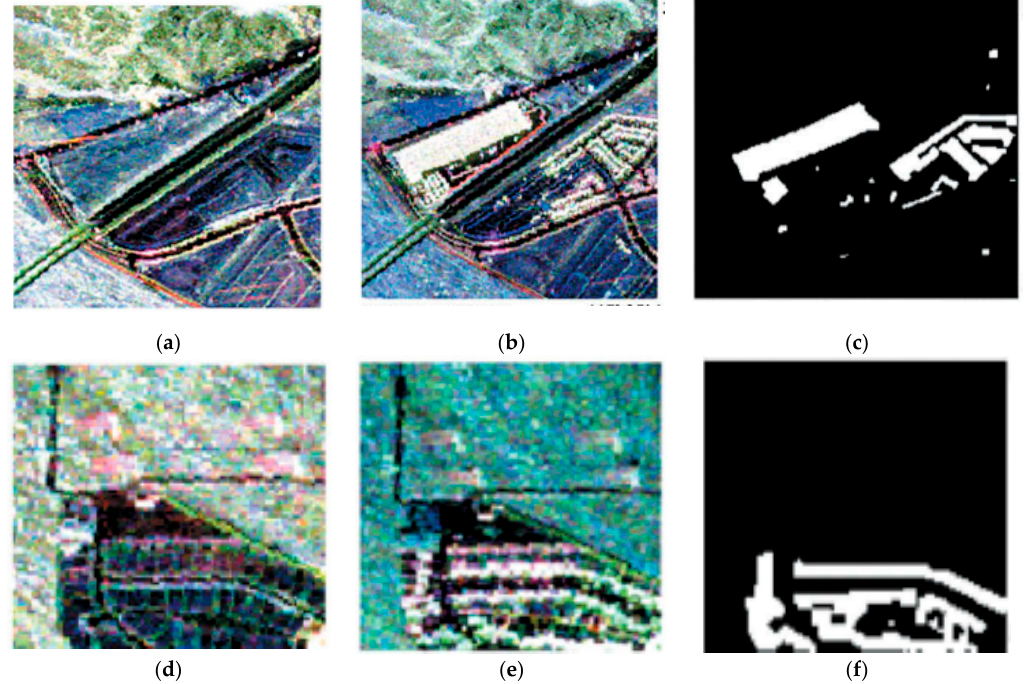
Figure 3. PolSAR dataset: ( a ) and ( b ) are the RGB composites generated from the Pauli decomposition (Red: |HH – VV|; Green: 2|HV|; Blue: |HH + VV|) for the PolSAR-San Francisco1 datasets, and ( c ) shows the corresponding binary ground truth data, which white and black colors indicate the change and no-change areas, respectively. ( d ) and ( e ) are Pauli RGB composite of the PolSAR-San Francisco2 images, and ( f ) shows the corresponding ground truth data in binary format, which white and black colors indicate the change and no-change areas, respectively. Note that (a) and (d) were acquired on September 18, 2009, and (b) and (e) were captured on May 11, 2015.